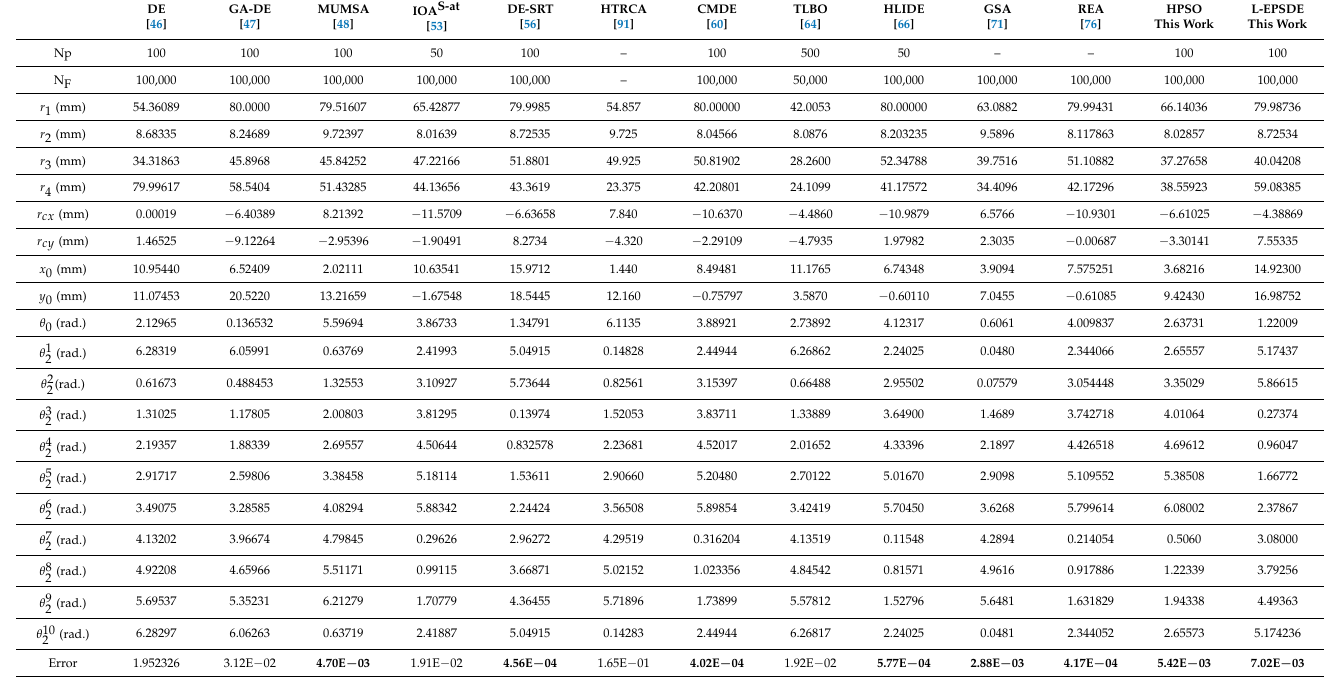
Table 7. The optimal results of HPSO, L-EPSDE, and eleven other optimization methods for Case